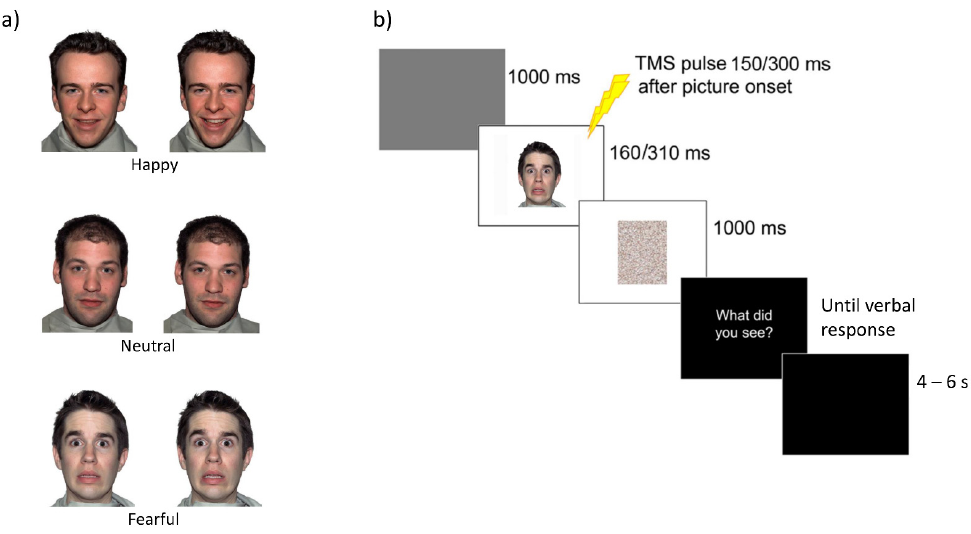
Figure 1. ( a ) Examples of visual body stimuli. ( b ) Trial sequence. In order to increase our pool of stimuli and to create faces showing different quanti- ties of happiness or fear (with matched intensity and recognition accuracy), we morphed the expressions of the five actors and generated a sample of 150 stimuli using the Fan- tamorph software (Abrosoft, PR, Italy; https://www.fantamorph.com (accessed on 1 March 2010)). The software allowed us to morph pairs of pictures of each actor and create transitions from neutral to emotional faces. For each model, two experimenters initially selected transitions near the two extremes (e.g., neutral and happy expressions or neutral and fearful expressions), so as to start from a pool of pictures showing slightly different, but not ambiguous, facial expressions. These 150 stimuli were initially presented to a sam- ple of 15 participants (2 males, mean age 25.1 y) who were asked to judge the intensity of happiness and fearfulness conveyed by each face using a 9 point Likert-like scale (from 1—no emotion/neutral–to 9—maximal emotional intensity). Based on the participants’ evaluation, we selected 105 stimuli where fearful and happy expressions were matched for emotional intensity. These 105 stimuli were entered in a second validation experiment, in which 24 participants (10 males, mean age 24.9 y) were requested to categorize the facial expression (3 forced choices: happy, fearful and neutral). Based on this further test, we selected the final sample of 54 pictures (18 for each expression) to be used in the TMS experiment. The selected pictures were accurately recognized with comparable percent- ages of correct responses (happy faces: 91%; neutral faces: 92%; fearful faces: 92%) and congruent ratings of happiness (happy faces: 5.66; neutral faces: 1.74; fearful faces: 1.17) and fear (happy faces: 1.06; neutral faces: 1.46; fearful faces: 6.21). 2.3. Transcranial Magnetic Stimulation and Electromyography Recording MEPs were collected in two separate sessions testing motor excitability of the right (M1right session) and left M1 (M1left session). Both sessions started with the electrode montage, detection of optimal scalp position and measurement of resting motor thresh- old. To explore motor excitability, single TMS pulses were delivered over the right and left M1, and MEPs were recorded from the first dorsal interosseus (FDI) muscles, contra-